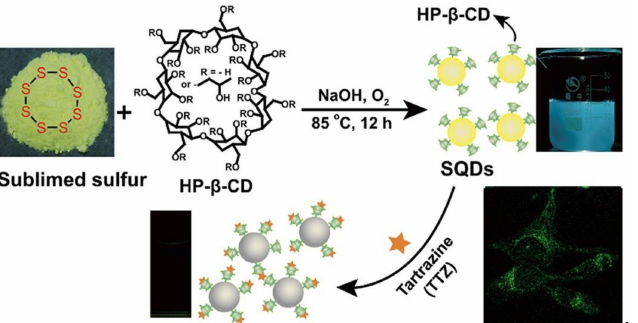
Figure 2. Schematic illustration for the sensitive and selective fluorescence detection of tartrazine based on the HP- β -CD capped SQDs (reprinted from [64] with permission from Elsevier). Tert-butylhydroquinone (TBHQ) is a general synthetic lipid antioxidant widely